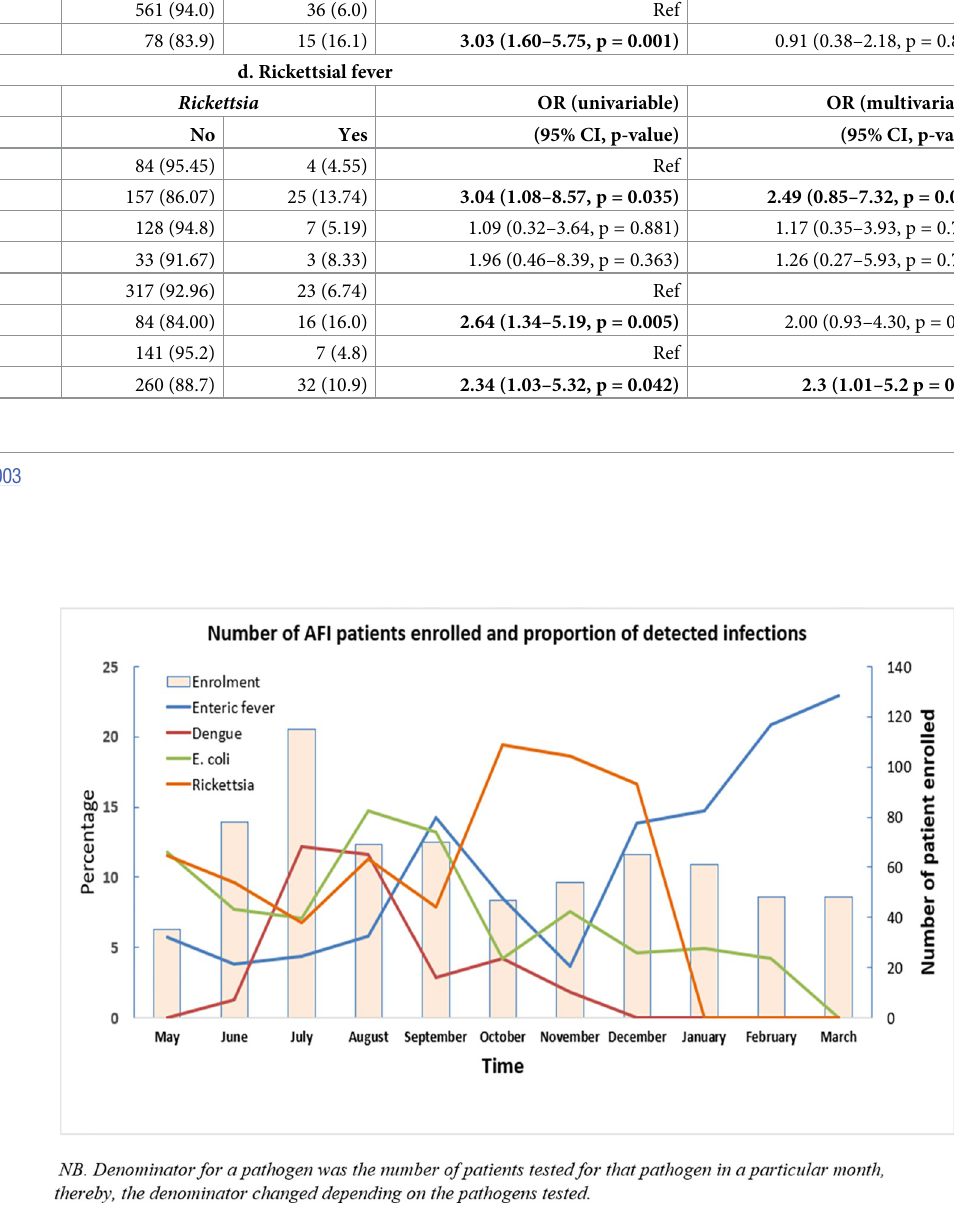
Fig 3. Proportionate distribution of the most common infections over time among the acute febrile illness (AFI) patients in Bangladesh, May 2019-March 2020.